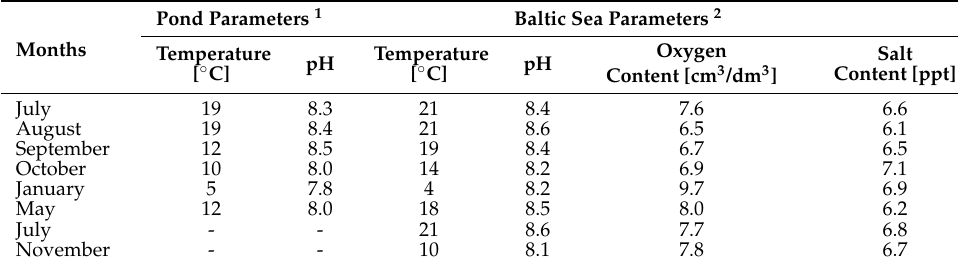
Table 1. The characteristic parameters of natural aqueous